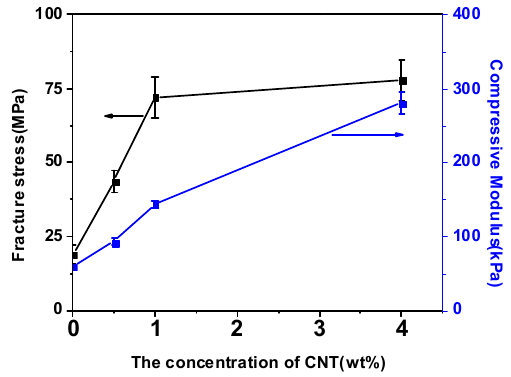
Figure 3. The fracture stress and compressive modulus of nanocomposite DN gels as a function of CNTs